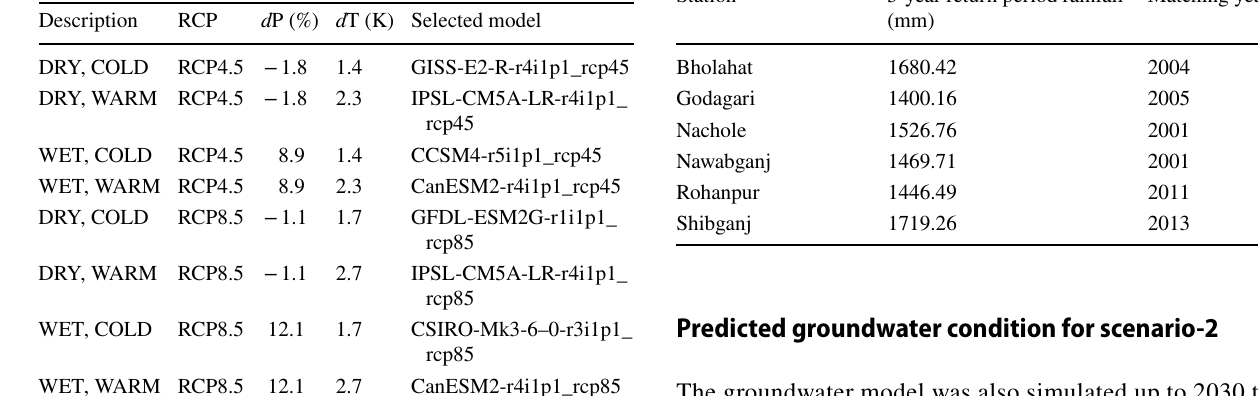
Table 2 Delta factor to project precipitation and temperature from 1961–1990 to 2021–2050 ( adopted from Immerzeel and Lutz 2012) Description